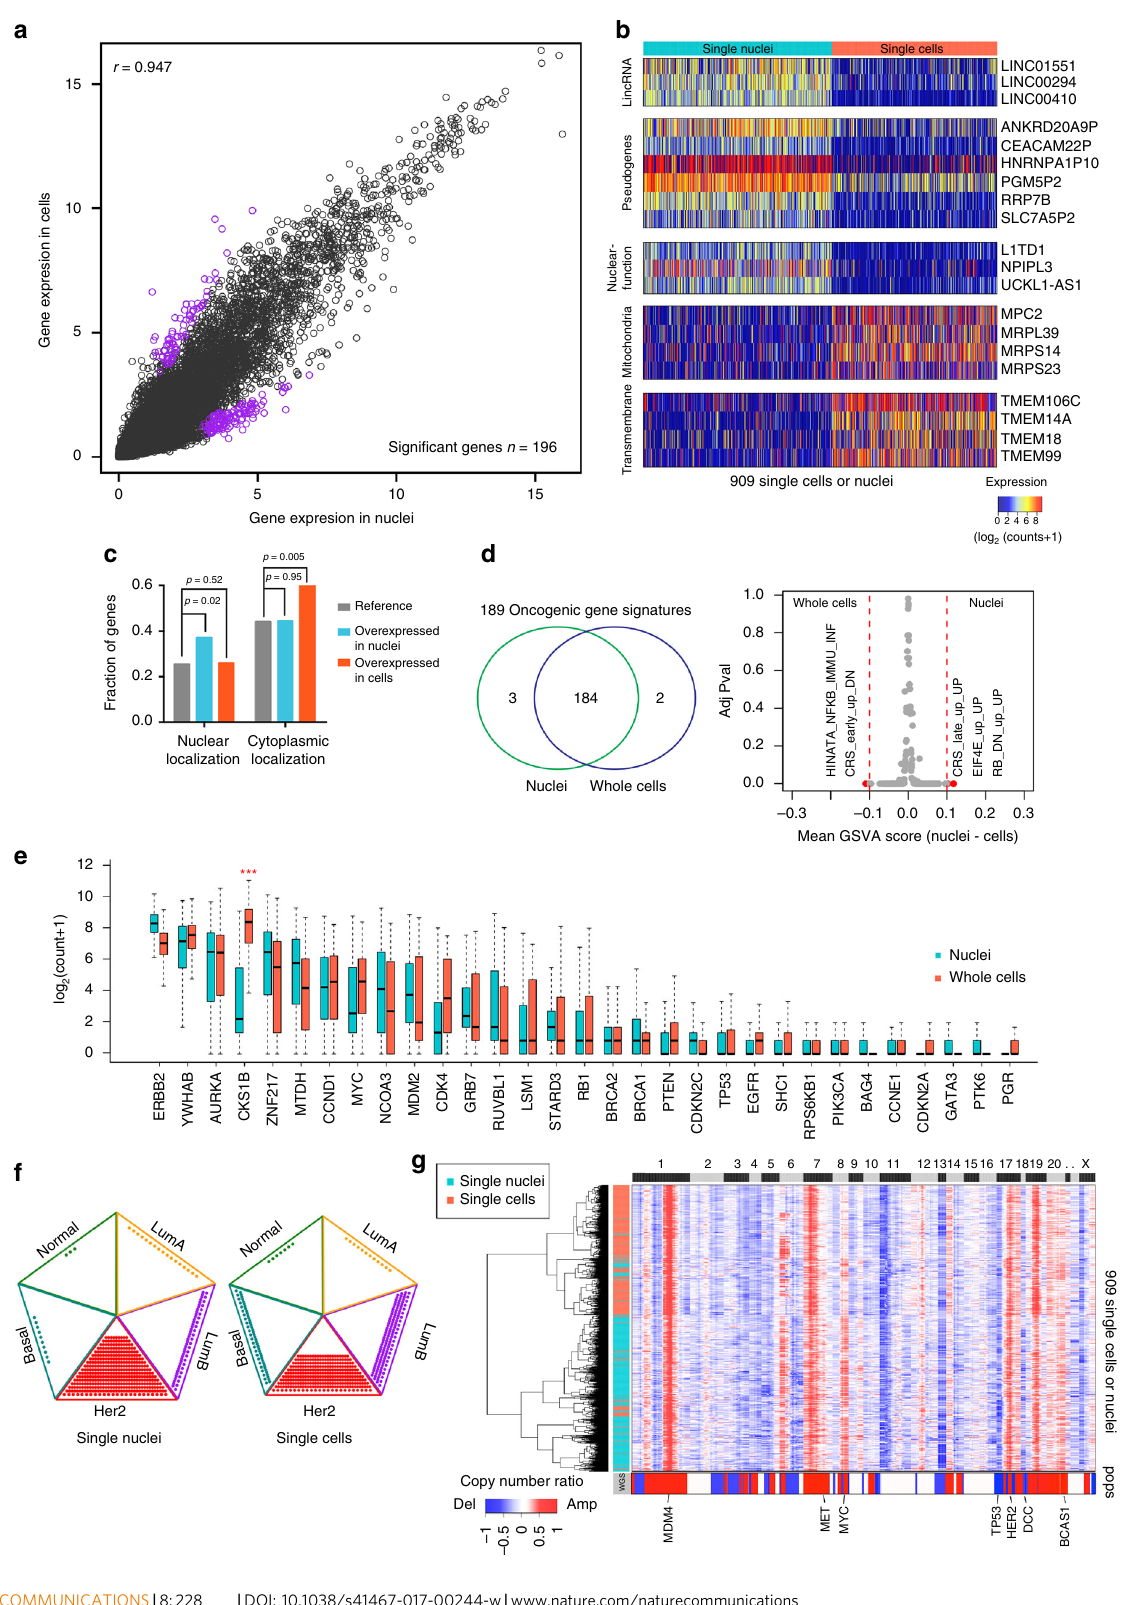
WBC identi fi ers for downstream data processing and analysis (Fig. 2f and Supplementary Fig. 4). Single nuclei and cell concordance in a cancer cell line . To determine if the transcriptional pro fi les of single nuclei